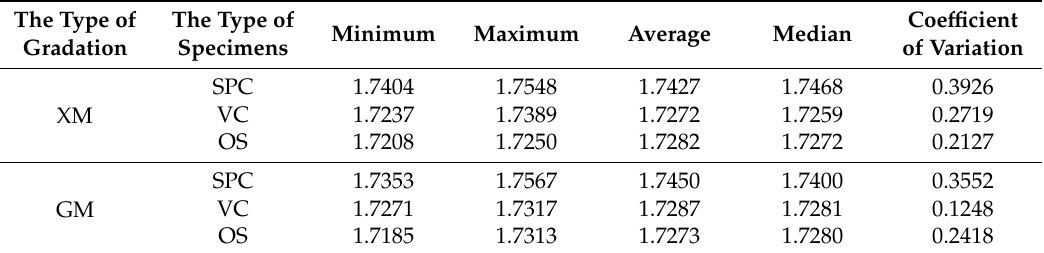
Table 11. Fractal dimension of void image of cement stabilized macadam mixture.